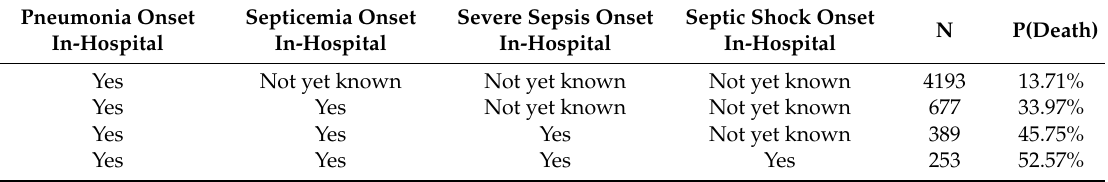
Table 4. Hospital onset of pneumonia-induced bloodstream